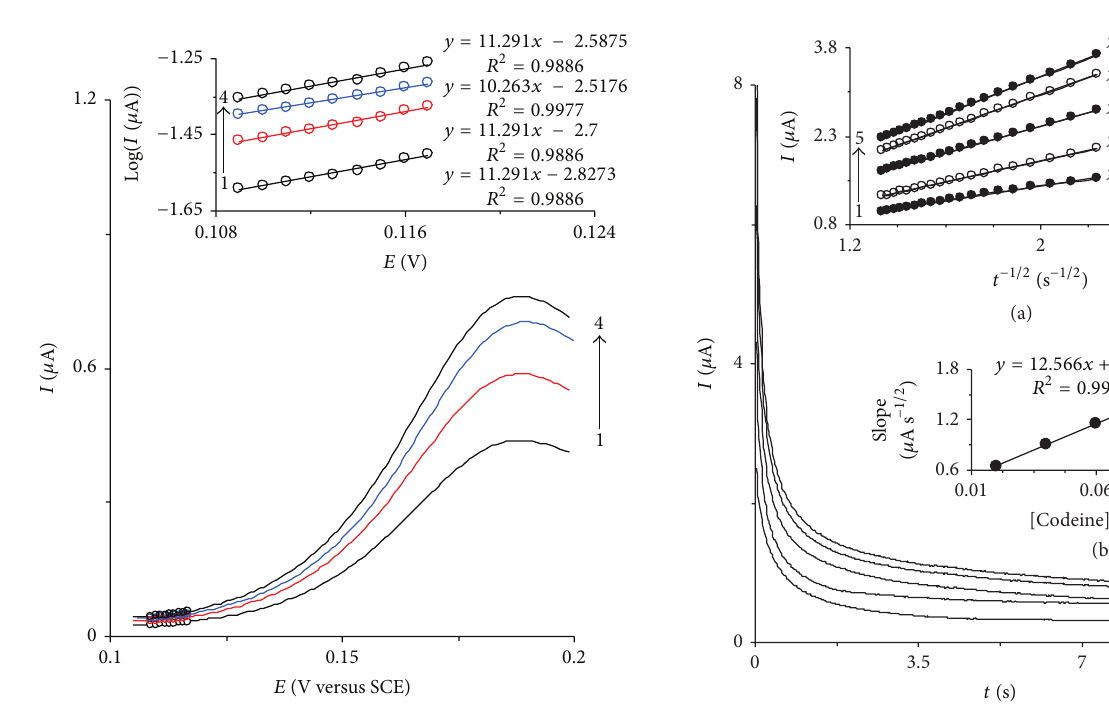
Figure3:CyclicvoltammogramsofHTP-MWCNT-CPEina0.15 M phosphate buffer solution (pH 7.0) containing 0.11mM of codeine at scan rates 2.5, 5, 7.5, and 10mVs −1 . The circles show the part of cyclic voltammograms that was used for deriving Tafel plot. Inset shows the Tafel plots derived from the circled current-potential curve recorded at scan rates of 2.5, 5, 7.5, and 10mVs −1 .